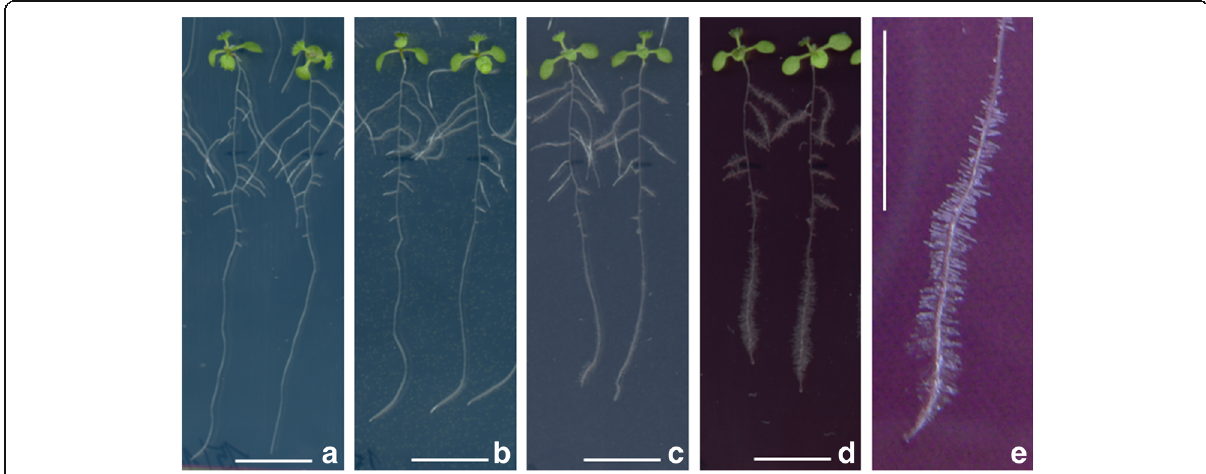
Fig. 4 Effect of different concentrations of 10 nm AuNPs on root hair growth in A. thaliana seedlings. a Control, b – d seedlings treated with 1, 10, and 100 mg/L of AuNPs, respectively, and e detail of induced root hair growth in plant exposed to 100 mg/L of AuNPs. The scale bars correspond to 1